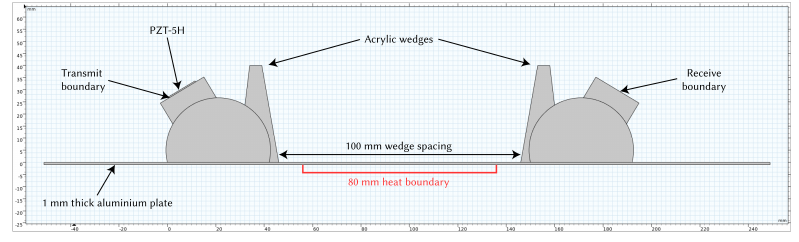
Figure 2. COMSOL geometry diagram.